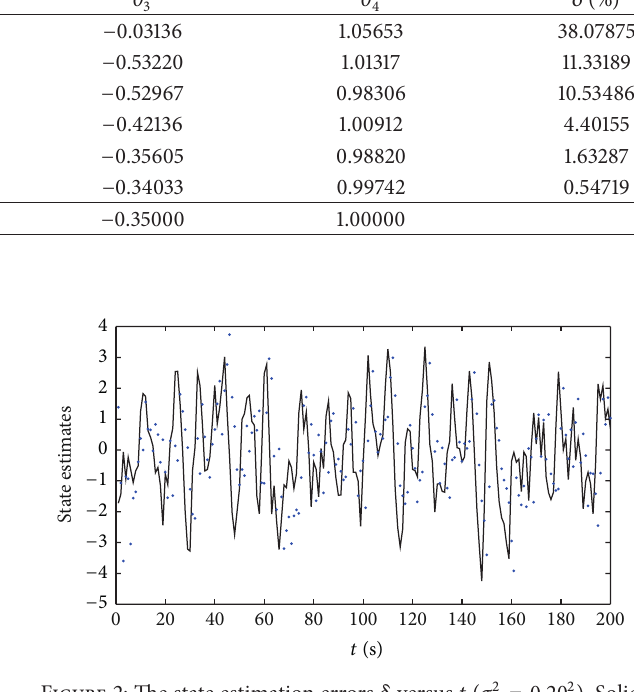
Figure 1: The parameter estimation errors 𝛿 versus 𝑡 ( 𝜎 2 = 0.20 2 and 𝜎 2 = 1.00 2 ).